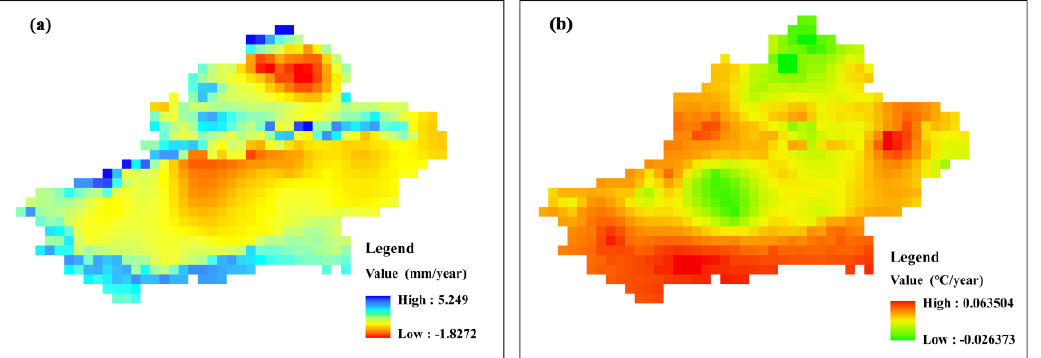
Figure 6. From 1989 to 2015: the rate of change in temperature and precipitation in Xinjiang: ( a ) precipitation, ( b ) temperature.